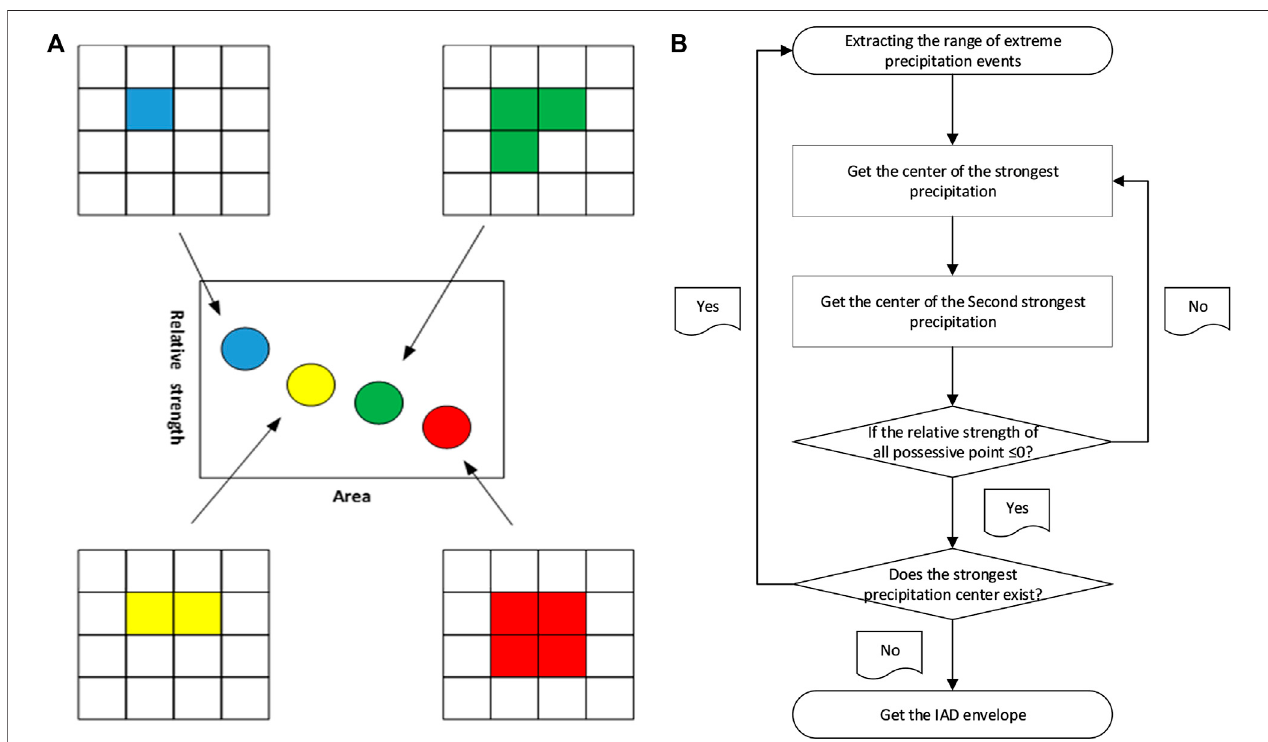
FIGURE 2 | Schematic diagram of identifying extreme precipitation events by the IAD method. (A) Distribution map of extreme precipitation events in different duration scales in the region. (B) Calculation steps of IAD identifying extreme precipitation events, which includes cyclic judgment calculation. The extreme precipitation events within the range are gradually identi fi ed according to the intensity until all identi fi cation is completed, and fi nally, the IAD envelope is obtained.